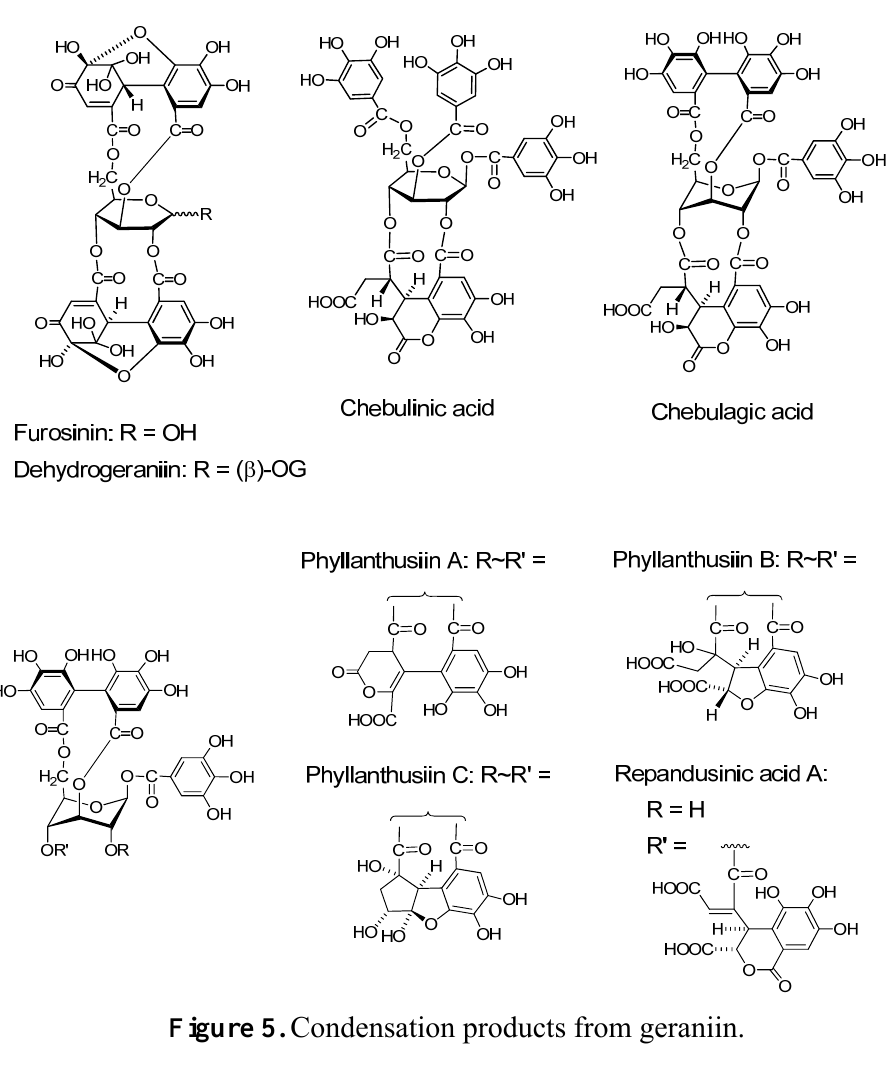
Figure 4. Dehydroellagitannins and oxidized congeners.